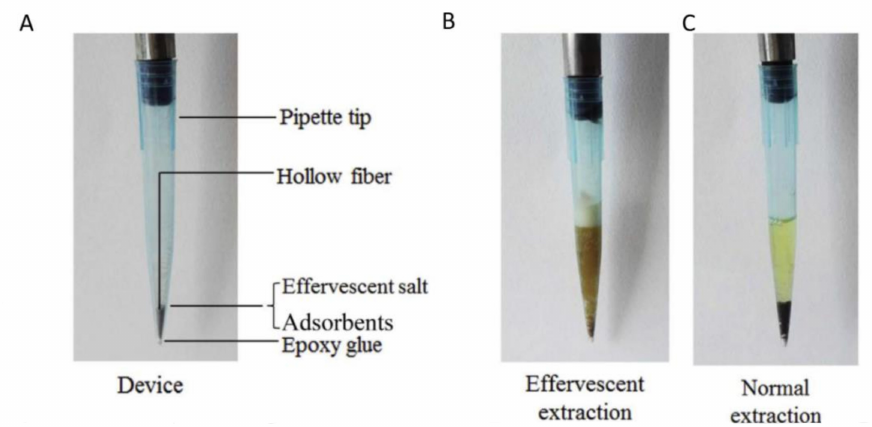
Figure 3. ( A ) E ff ervescence-Pippete Tip SPE device (EPT-SPE); ( B ) E ff ervescent extraction; ( C ) Normal extraction in absence of e ff ervescent precursors. Reproduced with permission of Elsevier from reference